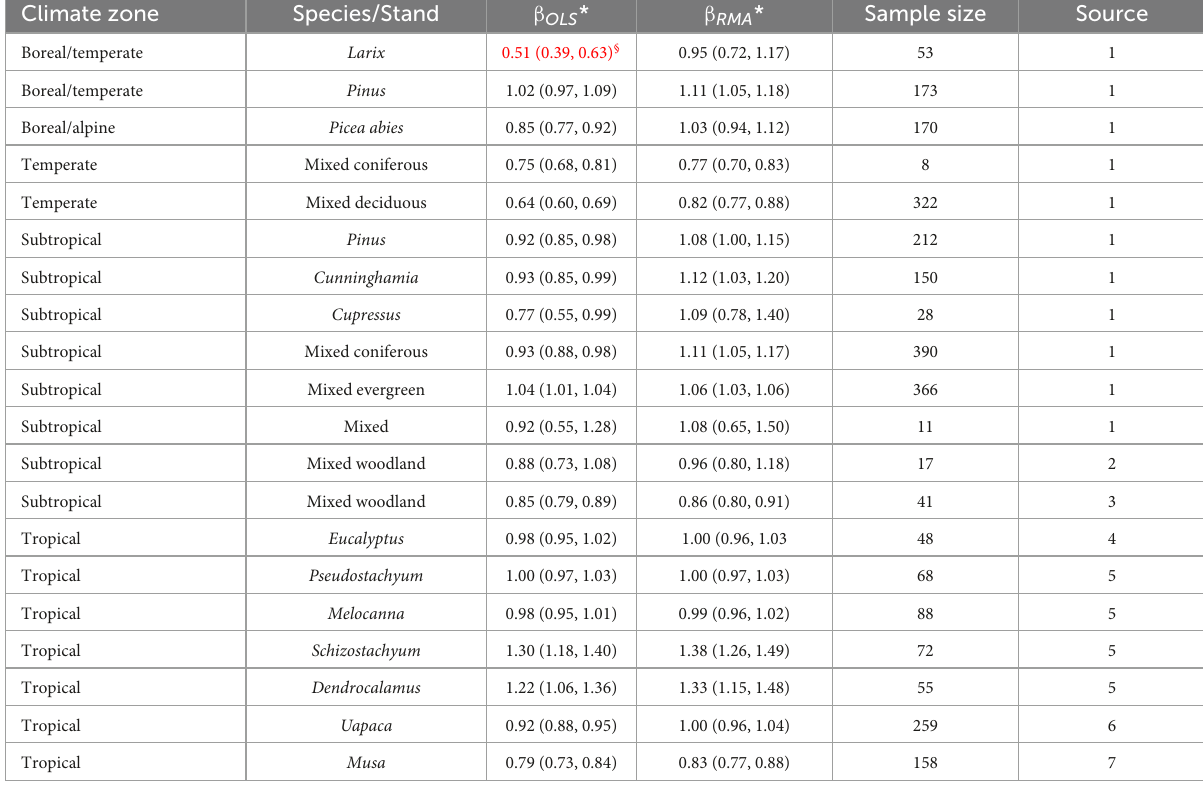
TABLE 6 Variations in the OLS and RMA estimates of the exponent ( β OLS and β RMA ) of the allometry of belowground biomass with aboveground biomass (B–A) in trees, bananas and bamboos across different climate zones and biomes. Climate